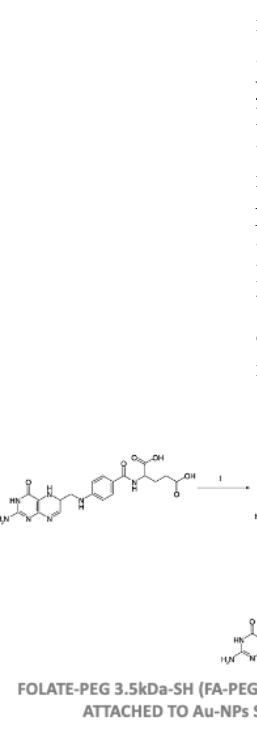
Figure 3. Gold nanoparticles (Au-NPs) can be decorated by adding the folic acid carboxyl group. Folic acid was activated by carboxyl groups by N-hydroxysuccinimide (NHS) and dicyclohexylcarbodiimide in anhydrous dimethyl sulfoxide (DMSO) and conjugation of NHS-ester activated folate to NH 2 -PEG3.5kDa-SH (FA-PEG-SH) in anhydrous DMSO in presence of triethylamine